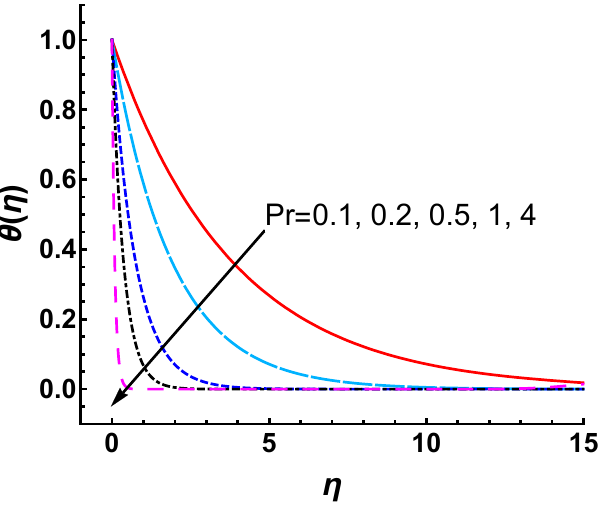
Figure 13. Influence of Pr on temperature profile θ ( η ) obtained by HAM with M = s = γ =